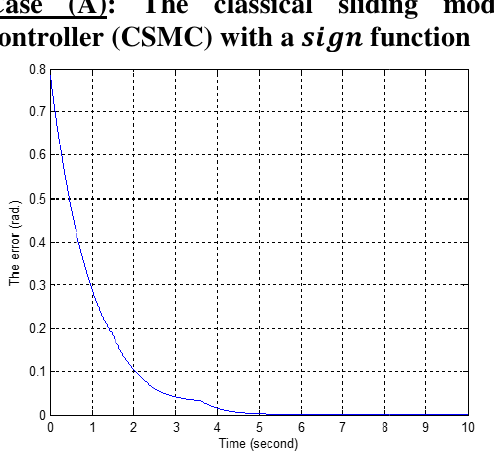
Fig. 7. The error _